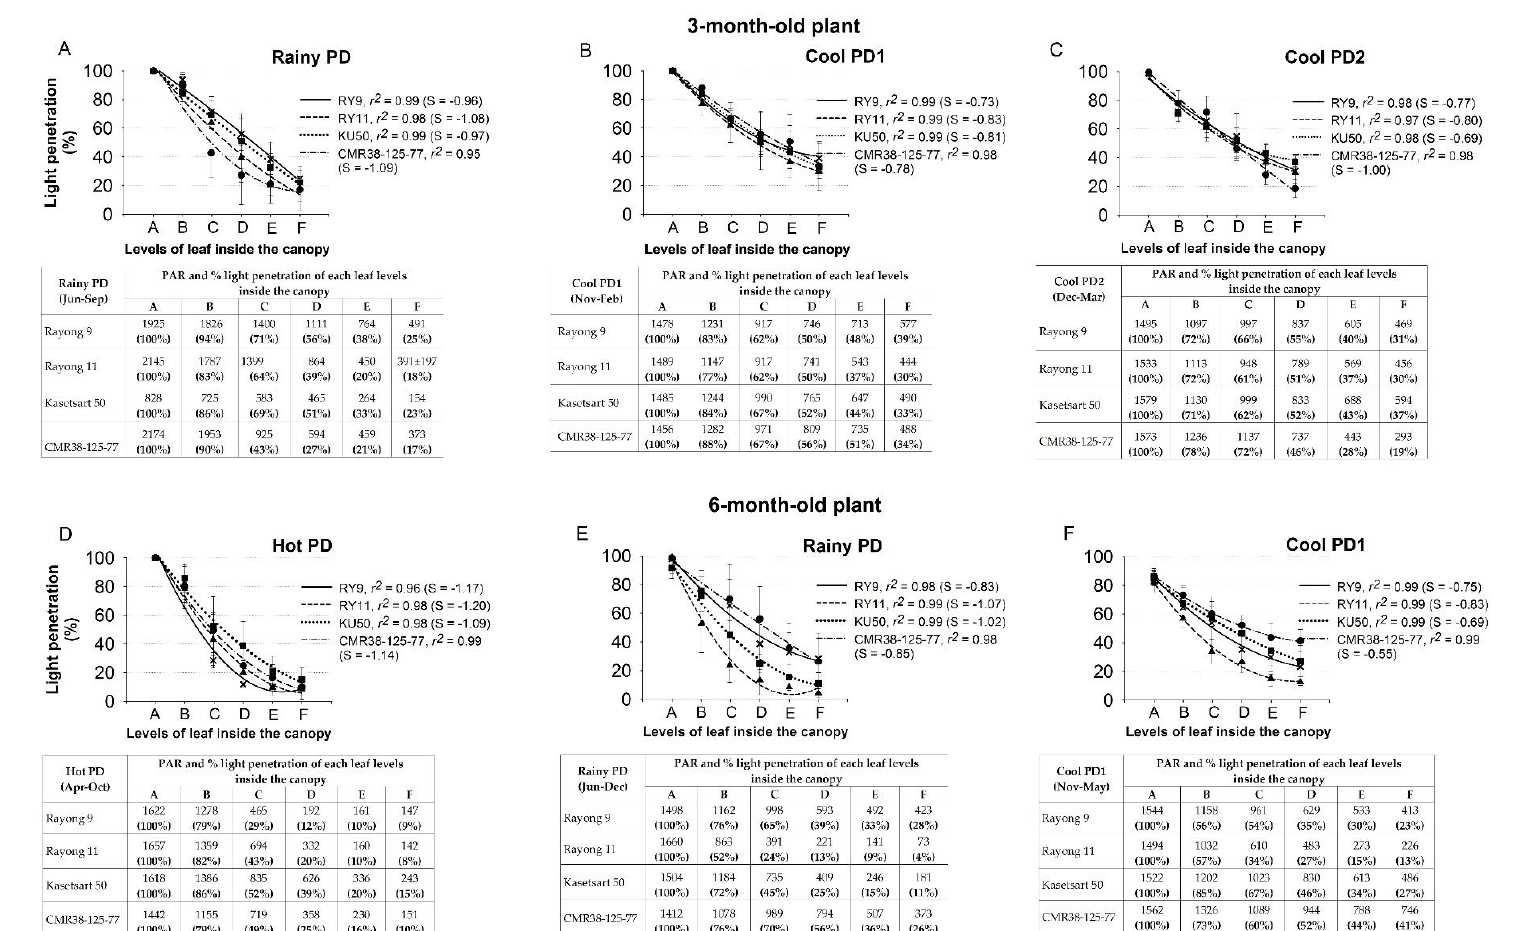
Figure 3. Percentage of light penetration through different canopy layers (Levels A – F) of the 3- and 6-month-old plants of cassava Rayong 9 (RY9; ), Rayong 11 ), and CMR38-125-77 ( ) planted in April (Hot PD; D ), June (Rainy PD; A , E ), November (Cool PD1; B , F ), and December (Cool PD2; ( C ) in 2015. The six canopy levels from A, B, C, D, E, to F were at the distance 17, 33, 50, 66, 88, and 100%, respectively, down from the shoot apex. Data show means of six plants (n = 6, two plants/replication).